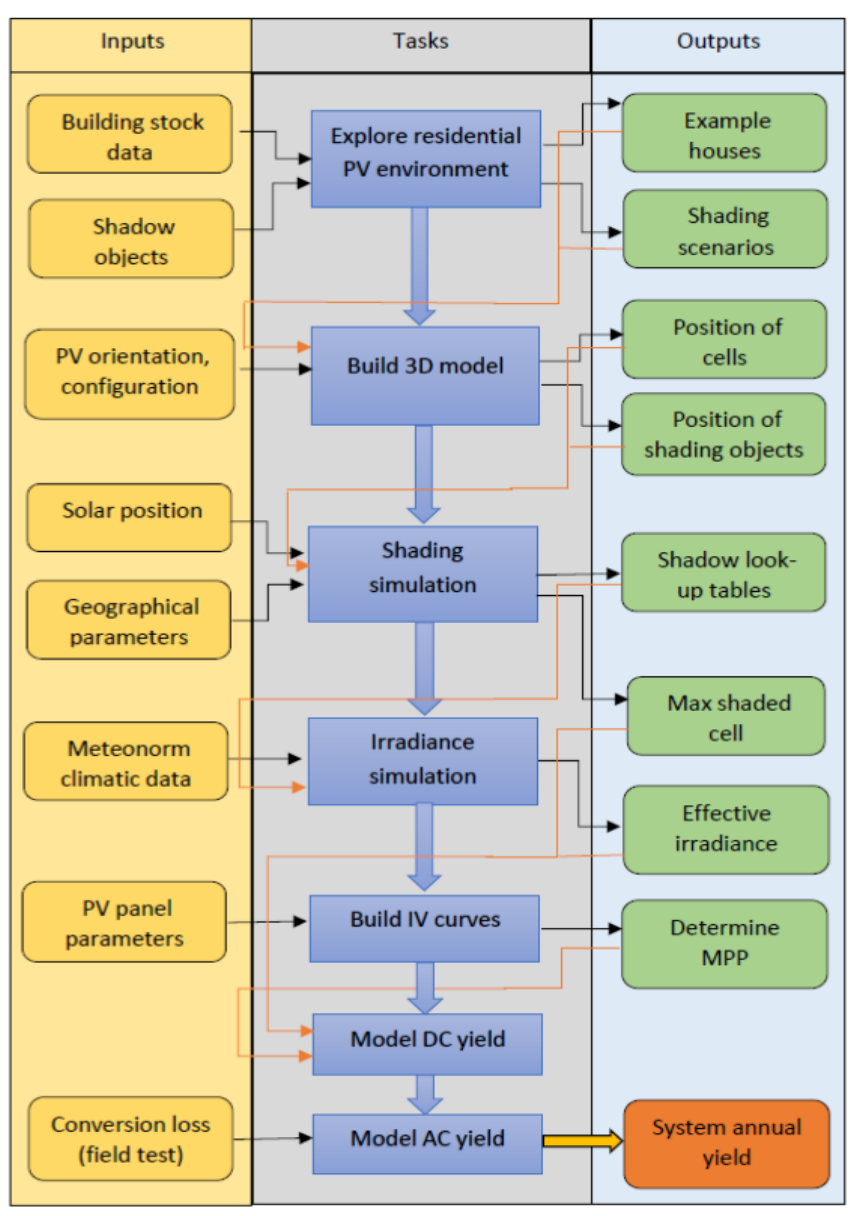
Figure 3. Flowchart of the simulation model.